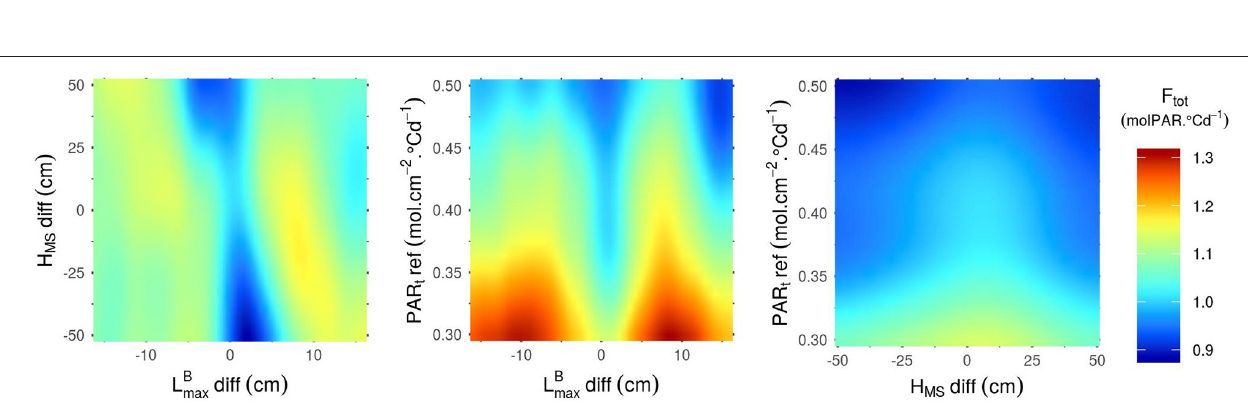
FIGURE 3 | Mean outputs predicted by the Kriging metamodels as a function of their two most influential input parameters. Predictions were made with all other parameters set to their mean values. Left: N ears as a function of L B max -diff and L B max -ref. Right: L perc as a function of GAI c -ref and L B max -ref.